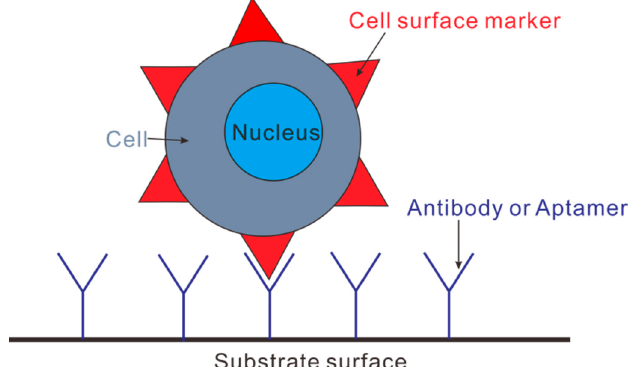
Figure 10. Schematic principle of immunocapture of a circulation tumor cell (CTC). An antibody or aptamer chemically immobilized on the substrate surface can be specifically linked with cell surface markers extruding from the cell membrane.